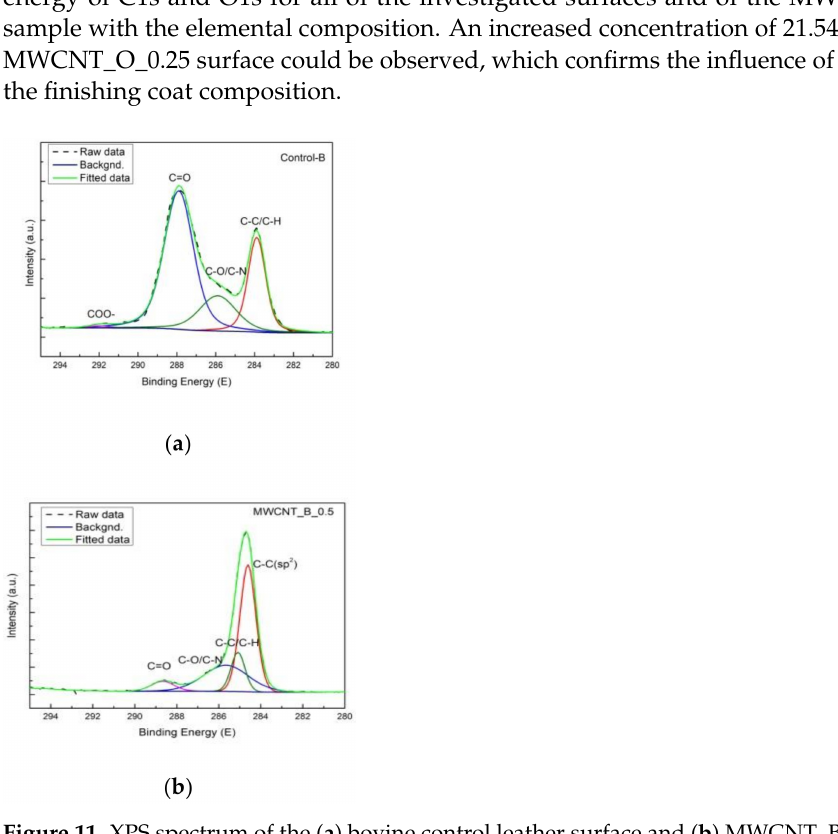
Figure 11. XPS spectrum of the ( a ) bovine control leather surface and ( b ) MWCNT_B_0.5.